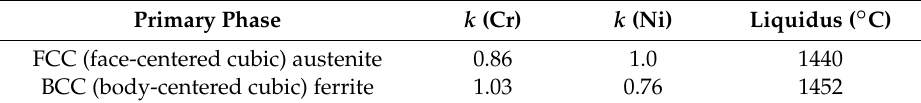
Table 4. Mass partition coefficients of nickel and chromium extracted from TCFE6 database, at the liquidus temperature for the composition (in wt. %) where the microsegregation profiles were measured in the transition zone: C = 0.052, Cr = 18, Mn = 1.6, Mo = 0.16, N = 0.03, Ni = 9.0, Si = 0.7, Fe =